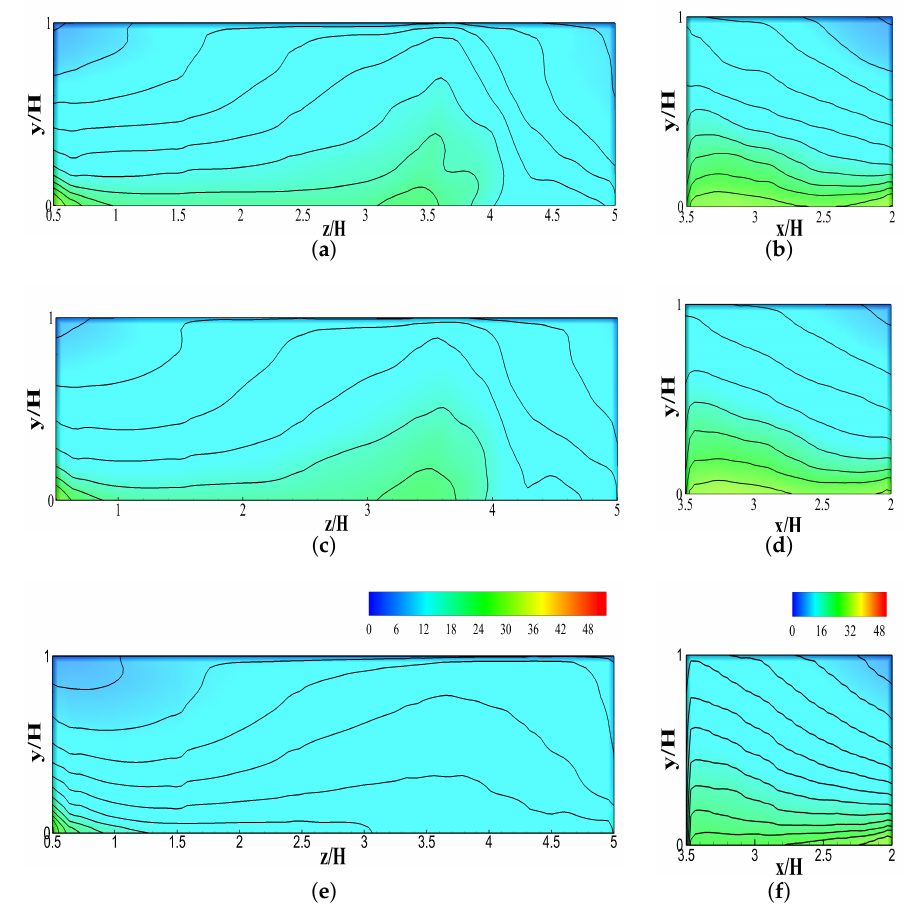
+ (cid:105) data on Building C (downwind